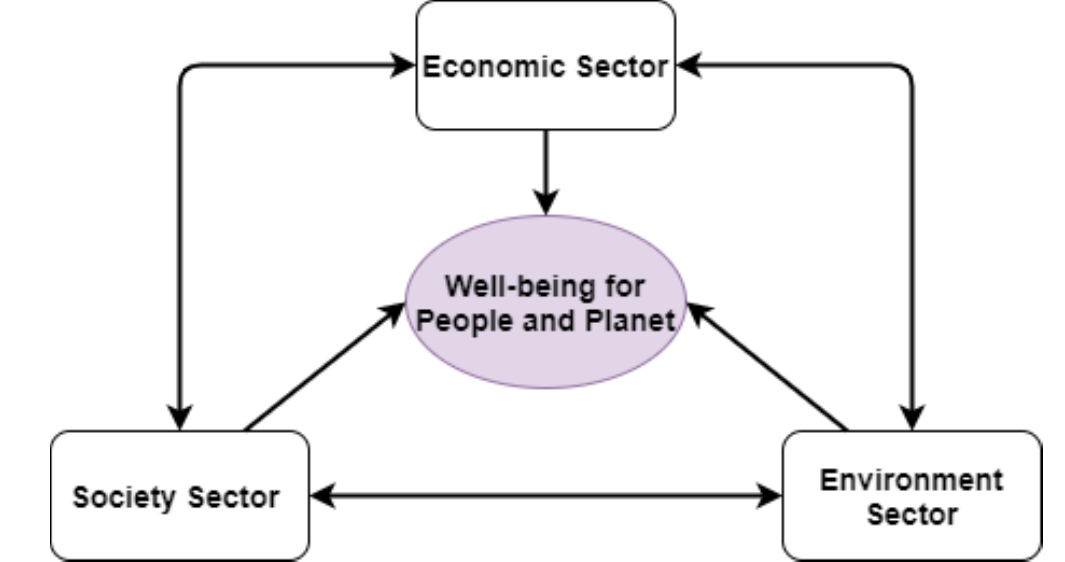
Figure 2. Three main sectors of the model.